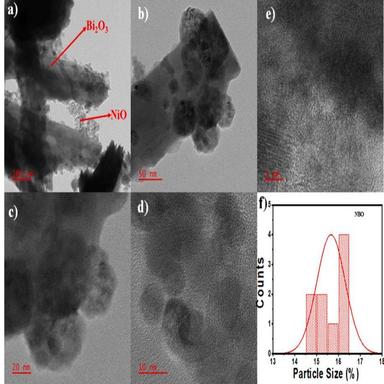
HRTEM images of a) to e) NBO nanocomposite material and f) histogram of NBO particle size.